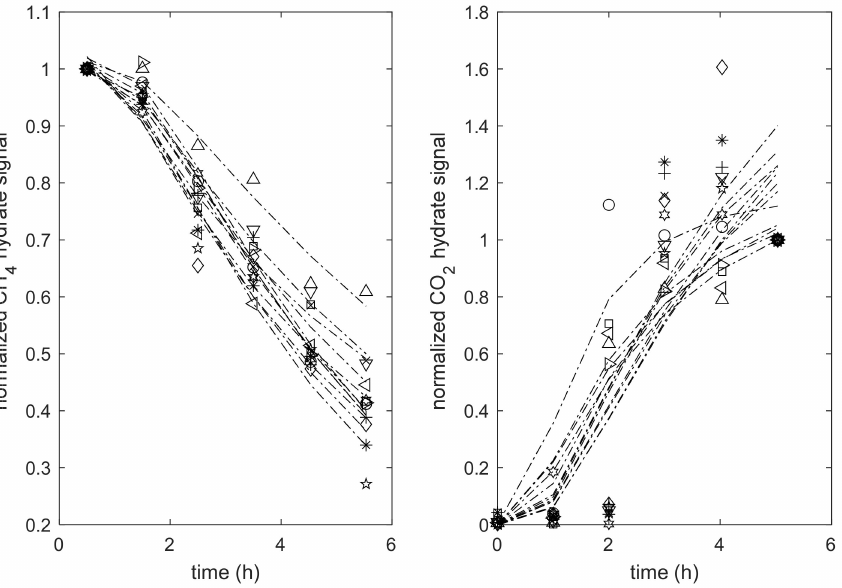
Figure 13. Time evolution of the CH 4 hydrate signal ( left ) and the CO 2 hydrate signal ( right ) on grains 6–17 with regressed curves. Different symbols denote different